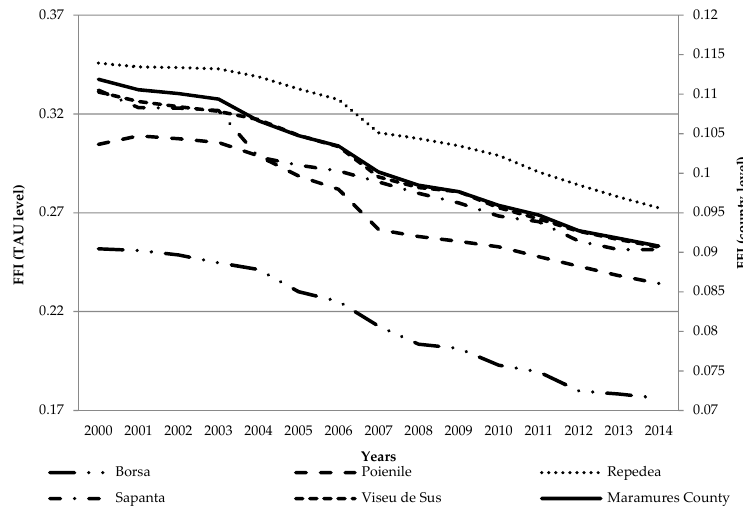
Figure 3. The temporal evolution of the FFI (Fractal Fragmentation Index) (2000–2014) at the county and TAU levels.